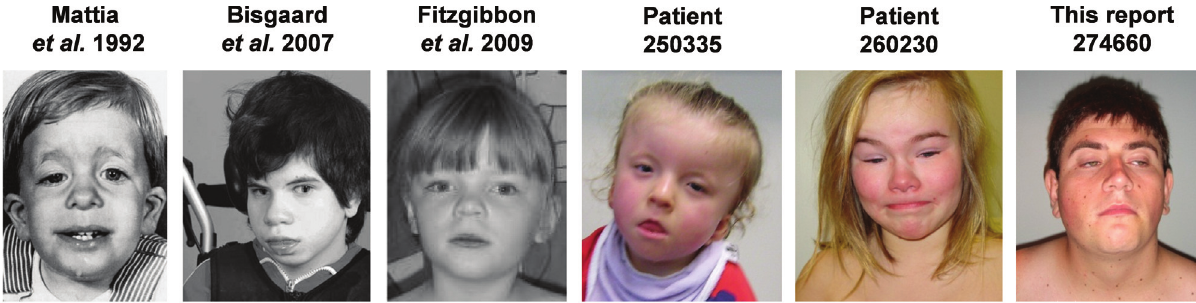
Figure1 -Frontalviewofpatientswithdeleted NRAS .PatientspresentfeaturesofNoonanSyndrome6,includingmacrocephaly,short/webbedneck,low hairline, skin abnormalities, triangular face with age, low-set ears, arched eyebrows, hypertelorism, ptosis, downslating palpebral fissures and epicanthal folds. Considering the patients with NRAS deletion, we did not have a picture of patient 253793 and